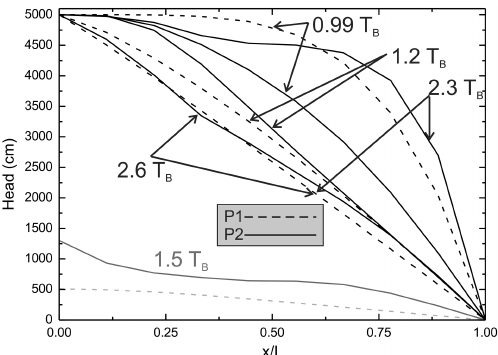
Figure 2. Profile of hydraulic head along pathways P1 (dashed lines) and P2 (full lines) from Fig. 1. Profiles are taken at differ- ent time steps, given in units of breakthrough time ( T B ). Gray lines show scenario with constant input at 1.5 T B (Fig. 1e).